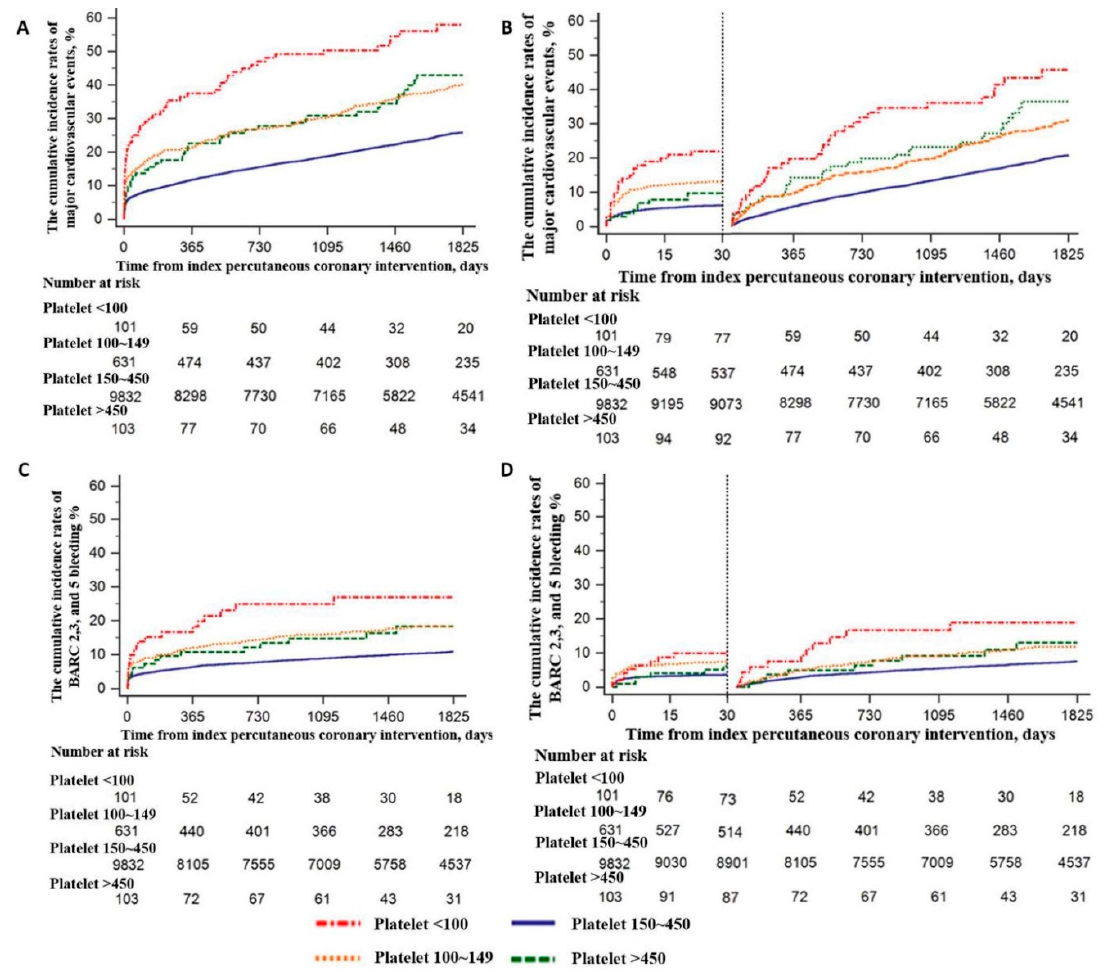
Figure 2. Kaplan–Meier curves for major cardiovascular events (MACE) and Bleeding Academic Research Consortium (BARC) 2, 3, and 5 bleeding according to the baseline platelet counts. ( A ) The 5-year MACE, ( B ) 30-day and 30-day to 5-year MACE, ( C ) 5-year BARC 2, 3, and 5 bleeding, ( D ) 30-day and 30-day to 5-year BARC 2, 3, and 5 bleeding.